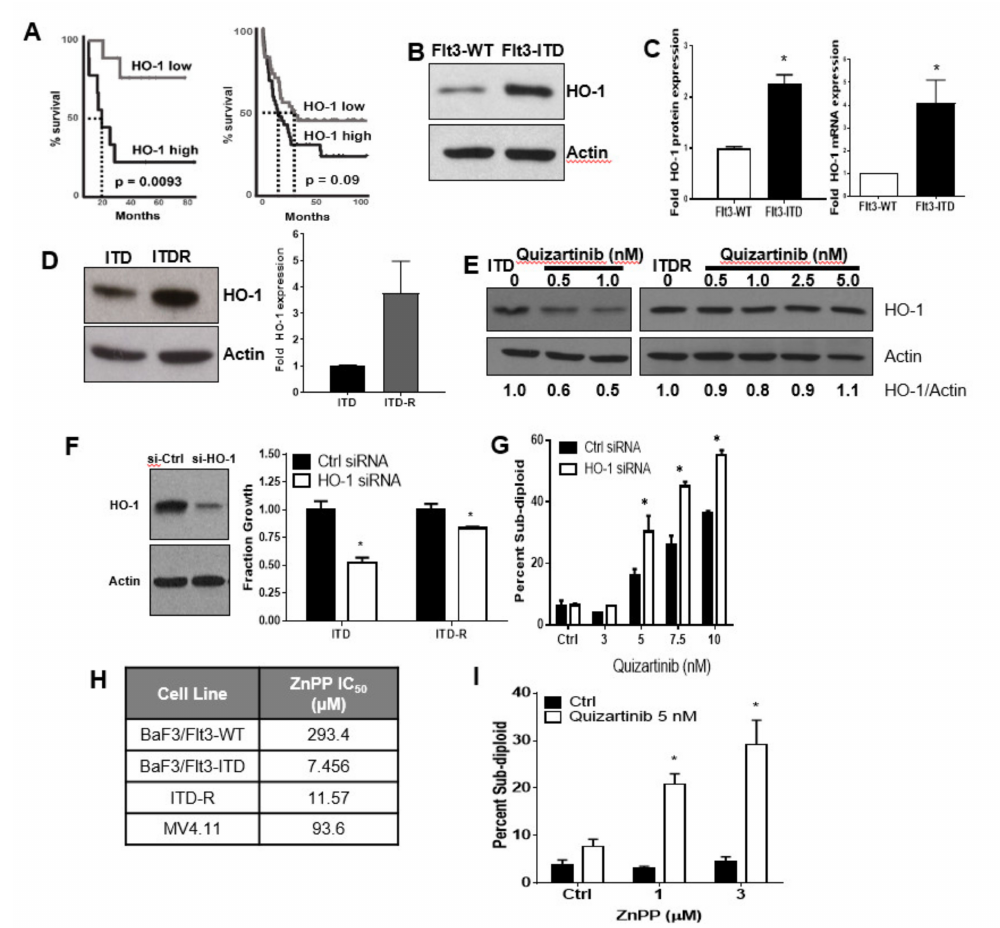
Figure 1. HO-1 promotes proliferation and survival in FLT3-ITD expressing AML. ( A ) Kaplan–Meier survival curves show a significant increase for the overall survival of the low HO-1 gene-expressing patient population ( n = 9) compared to the high HO-1-expressing Flt3-ITD-positive AML patients ( n = 9) (left panel) versus no significant difference in non-FLT3-ITD mutant AML patients (right panel) in high ( n = 42) versus low ( n = 41) HO-1 expression (TCGA data). ( B ) FLT3-WT or FLT3-ITD) cell lysates (50 µ g/lane) were loaded and the Western blot was performed for HO-1 and actin. ( C ) HO-1 mRNA gene expression in FLT3-WT and FLT3-ITD mutant-expressing BaF3 cells are shown by q-RTPCR assay. ( D ) FLT3-ITD mutant BaF3 cells (ITD) and a novel model of acquired pan-FLT3- inhibitor resistance BaF3-ITD cells (ITD-R) were used for protein lysate preparation, and Western blot analysis (50 µ g/lane) for HO-1 and actin protein levels was performed with densitometry shown adjacent. ( E ) HO-1 protein expression in BaF3-ITD and -ITD-R cells treated with a second-generation FLT3 kinase inhibitor at the indicated concentration were used for protein lysate preparation and te detection of HO-1 and actin protein (50 µ g/lane) levels by Western blot analysis. ( F ) Parental BaF3-ITD and ITD-R cells were transfected with si-HO-1 and scramble control si-RNAs after 48 h. Cell lysates were loaded on SDS-PAGE for the detection of HO-1 and actin by Western blot analysis (( F ) left panel). Cell proliferation assay from HO-1 knock down cells shown on the ( F ) right panel. ( G ) HO-1 knocked down cells (ITD-R) were treated with quizartinib at the indicated concentration for 48 h. Stained with propidium iodide for the detection of percent of sub-diploid cells measured by flow cytometry. ( H ) A competitive inhibitor of HO-1, ZnPP, was directly used for the treatment of FLT3-WT, -ITD, and ITDR cells. The mean IC 50 values found for three experiments are given in the table. ( I ) Bar diagram shows percent sub-diploid cells from the ratio of the mean DNA content of FLT3-ITDR cells treated with a combination of ZnPP and quizartinib at the indicated concentrations were measured by flow cytometry. Statistical significance is shown as p -values less than 0.05 (* p < 0.05). Each experiment was performed at least three